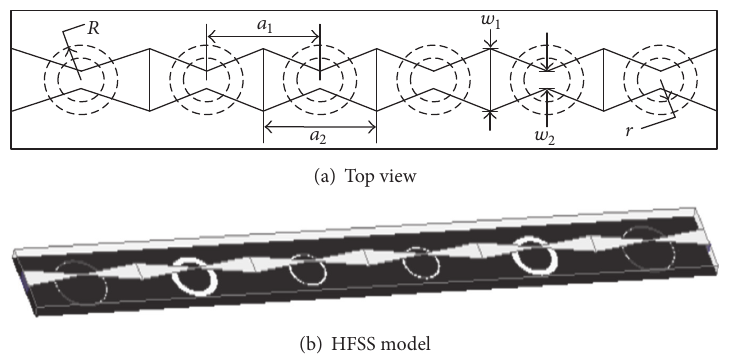
Figure 9: Structure of papilionaceous dual-plane EBG.